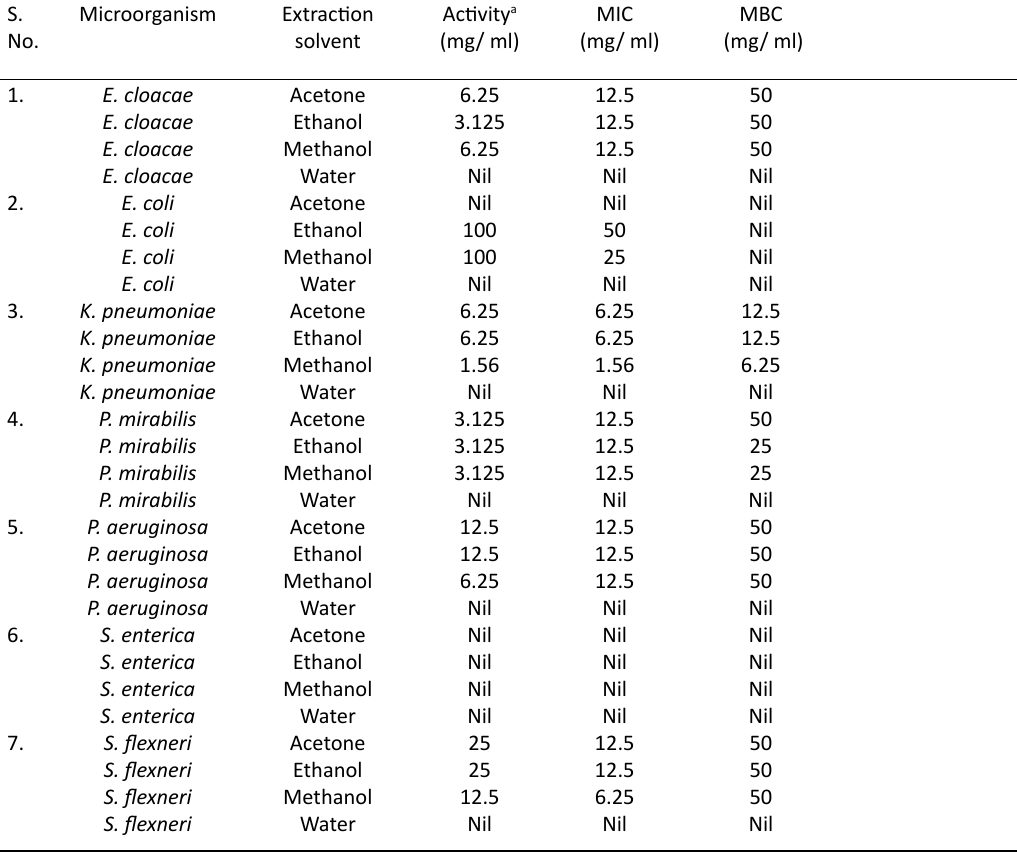
Table 2. Antibacterial activity, minimum inhibitory concentration (MIC) and minimum bactericidal concentration (MBC) of acetone, ethanol, methanol and water extracts of Cyclamen persicum tubers on different pathogenic Gram negative bacteria.